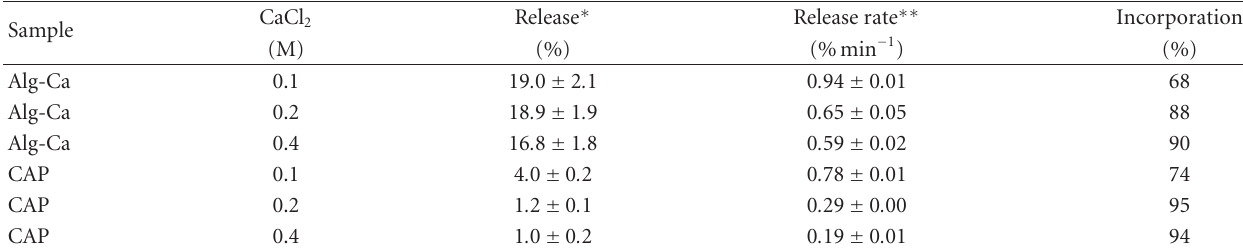
Table 1: Release parameters of DF from Alg-Ca or CAP prepared with 0.8% AP.